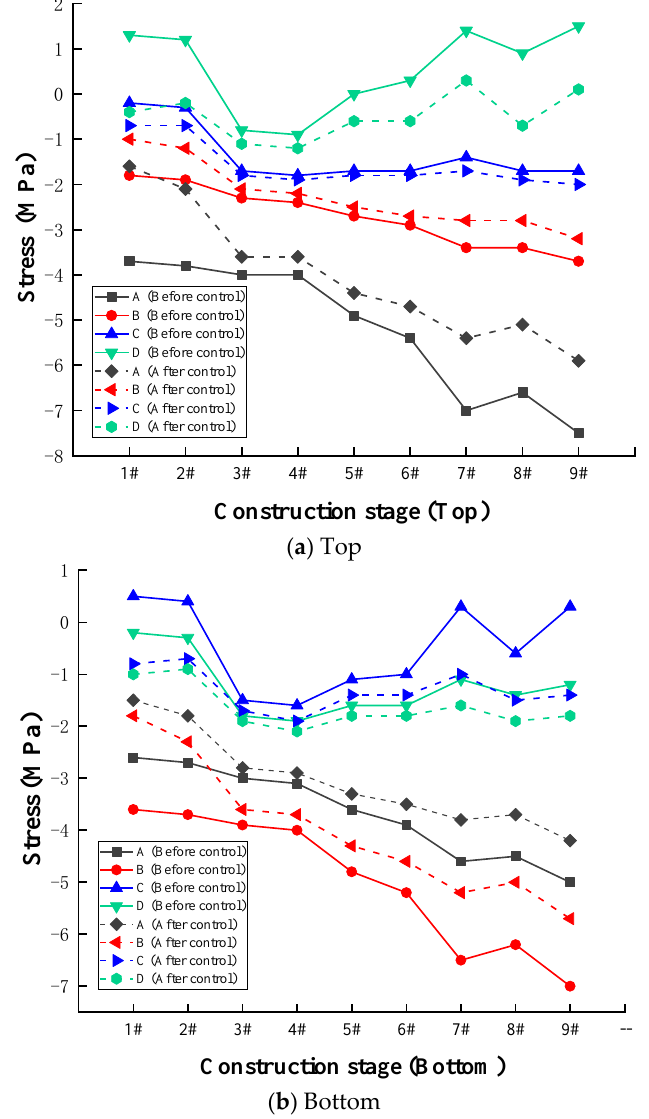
Figure 15. Stress of the compressive column (MPa).